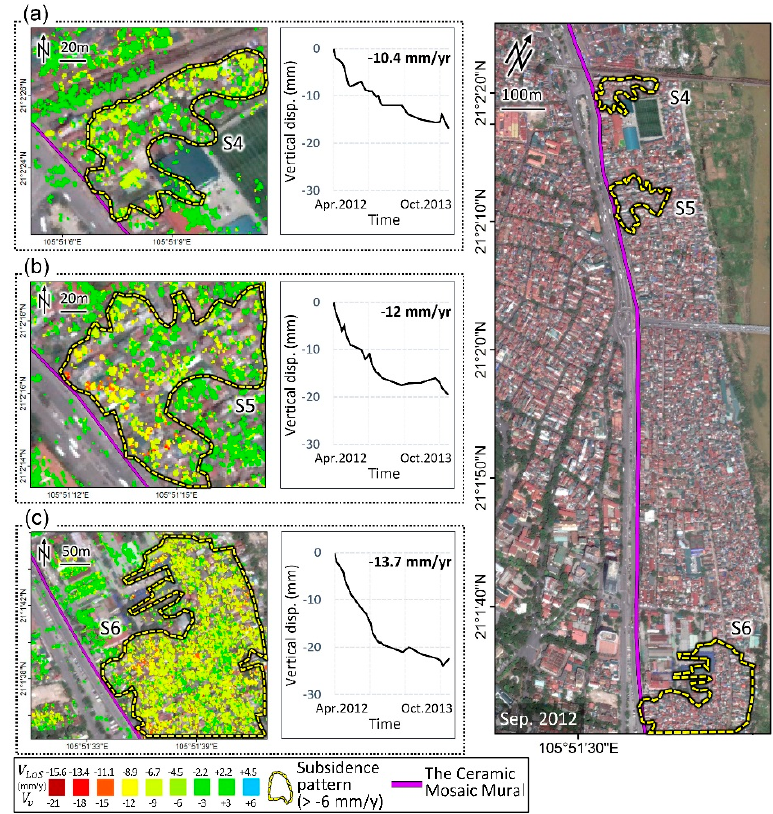
Figure 7. Average from April 2012–November 2013. LoS velocity map, temporal evolution chart and optical image represent location of subsidence pattern in ( a ) Phuc Tan 1 (S4), ( b ) Phuc Tan 2 (S5) and ( c ) Hong Ha (S6). Characters in parentheses denote the label of subsidence patterns in Figure 4.